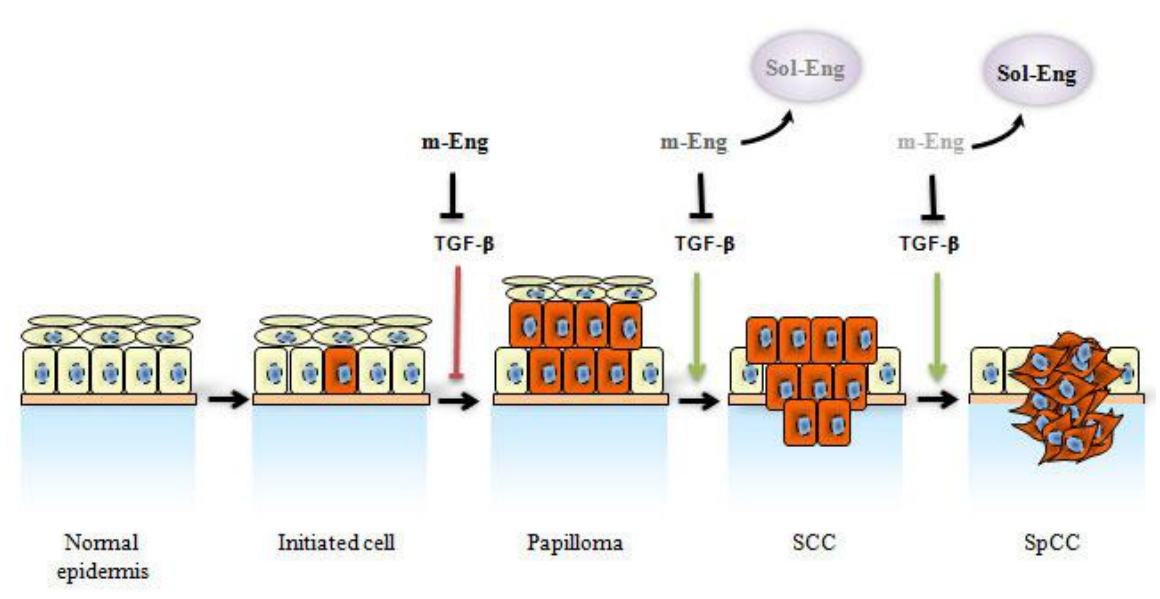
FIGURE 4 . Schematic representation of the different stages of chemical mouse skin carcinogenesis. The keratinocyte in the epidermis colored in brown represents a cell with Hras1 mutation initiated by DMBA. Mutated Hras1 gene expression increases during tumor progression. TGF-β1 behaves as a tumor suppressor at early stages of carcinogenesis, but promotes tumor progression at later stages. Proteolysis of m-Eng to produce Sol-Eng mainly occurs during the transition from SCCs to SpCCs. m-Eng, which inhibits TGF-β signaling in keratinocytes, behaves as a suppressor of malignancy at later stages of